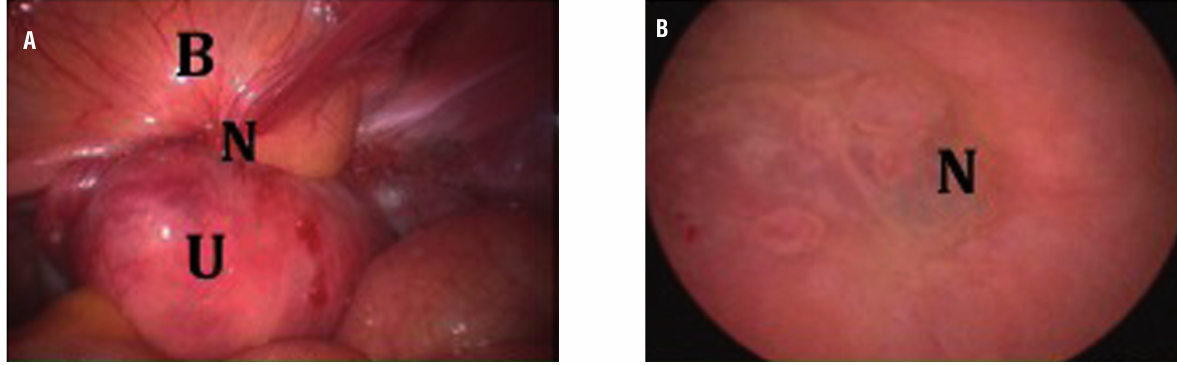
Figure 1D, (a) (left): laparoscopic view; ( B =Bladder, N =Node, U =Uterus); Figure 1D, (b) (right): cystoscopic view;